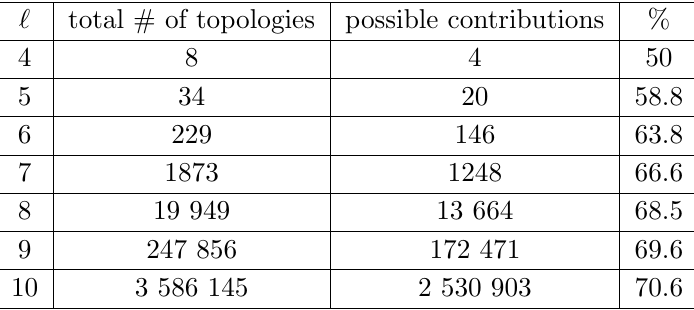
Table 1 . Number of topologies contributing on the cut through ten loops